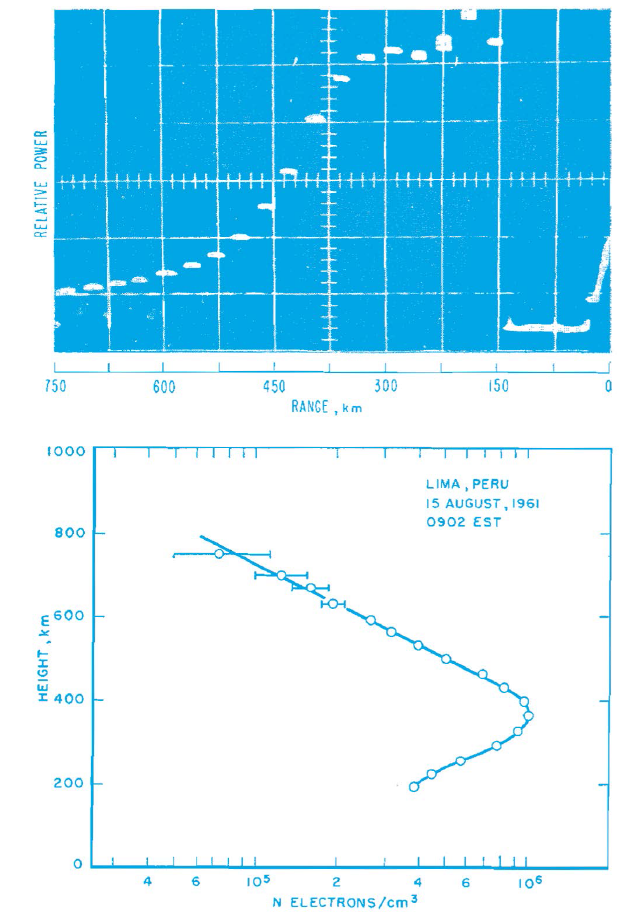
Figure 13. In the top panel is an oscilloscope photograph taken on 15 August 1961 at 09:02EST after sufficient integration time. In the bottom panel is the corresponding estimated electron density profile (adapted from Bowles et al.,